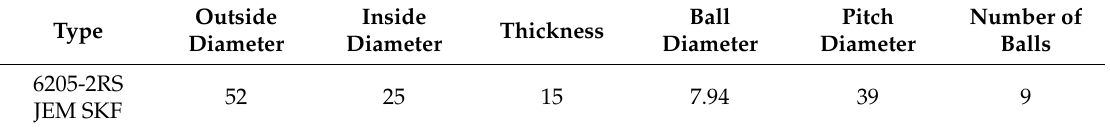
Table 1. The employed drive end (DE) bearing parameters (mm) in Experiment 1.